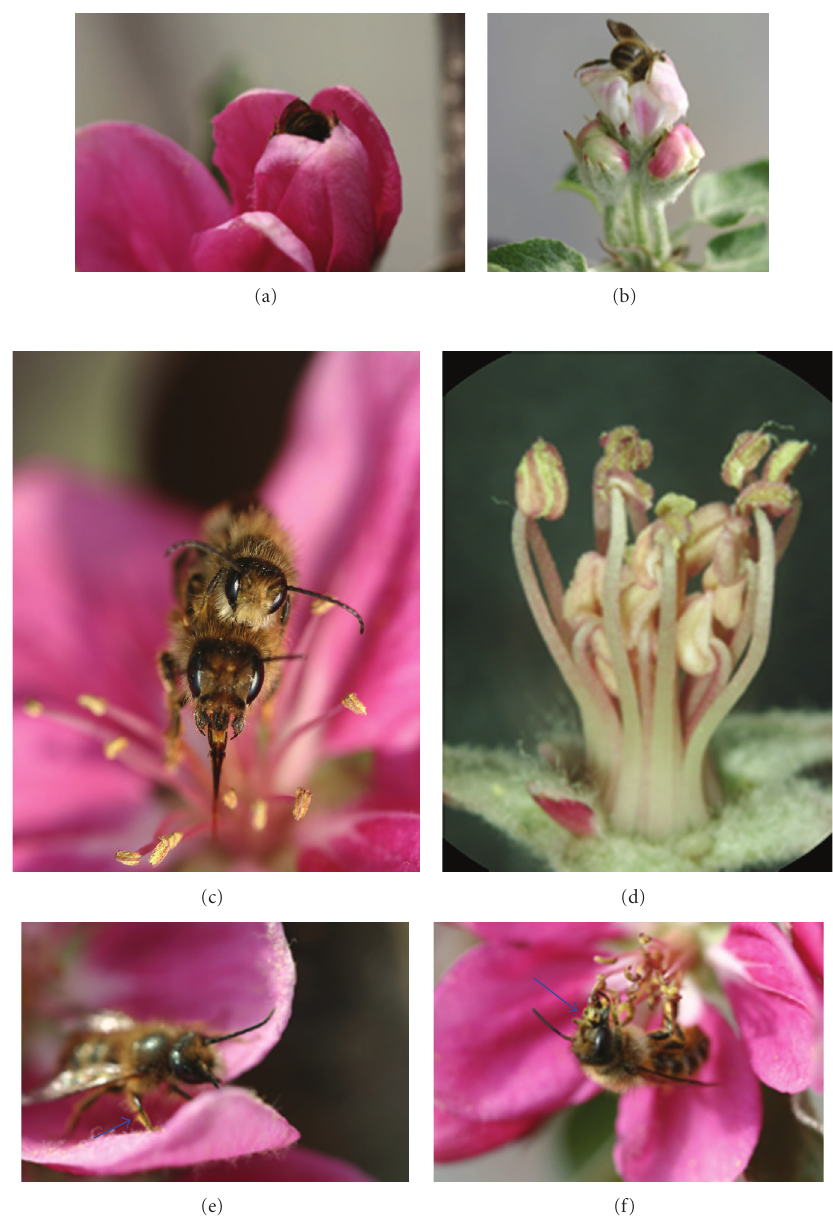
Figure 3: Osmia cornifrons visiting balloon stage flowers. (a) O. cornifrons visiting “Maypole”, (b) O. cornifrons visiting “Fuji”, (c) O. cornifrons male mounted on female drinking “Maypole” nectar, (d) Dehiscere anthers within a balloon-stage “Maypole” (Petals removed.), and (e) and (f) Pollen grains adhered to male’s leg (e) and female’s mouth